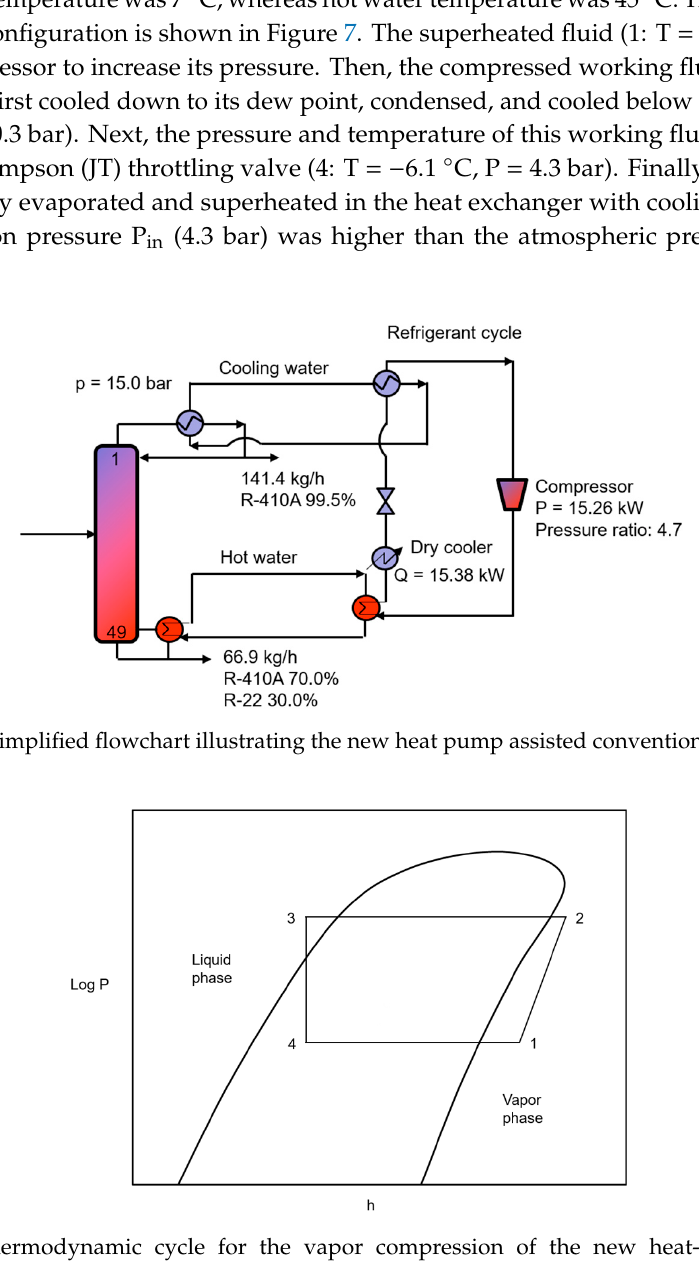
Figure 5. Simplified flowchart illustrating the VC heat-pump-assisted conventional column.